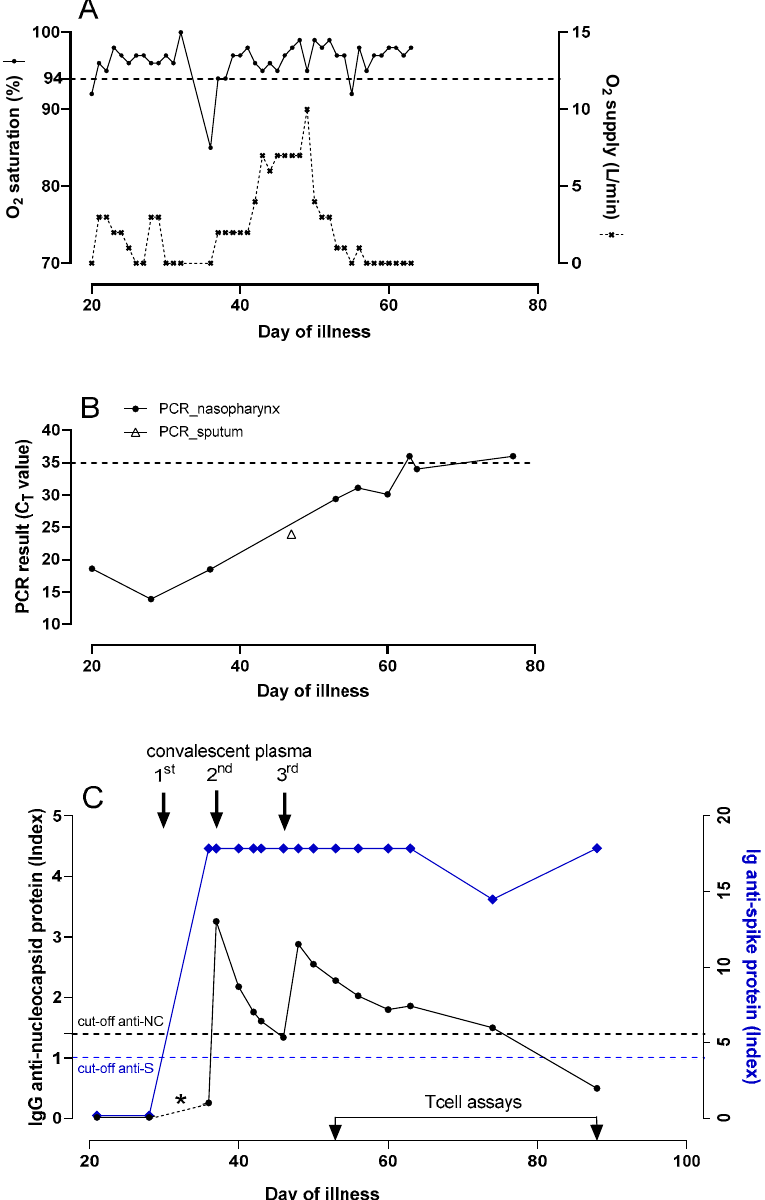
Figure 2. Clinical status, PCR results and serological responses in a patient with prolonged COVID-19. Time course of clinical status, PCR results and serological values. ( A ) Oxygen supplementation and saturation level during the admission periods. ( B ) PCR results of nasopharyngeal swabs and one sputum sample (Ct value means cycle threshold: a high value indicates a low amount or viral RNA and vice versa). The cut-off is indicated with an interrupted line. ( C ) Results of serological assays. Anti-NC was measured repeatedly during admission. The anti-S antibodies were measured only retrospectively. The cut-off values for both assays and the three time points of administration of convalescent plasma are indicated. The results of the T cell assays are shown in Figure 3 and Supplementary Figures S3 and